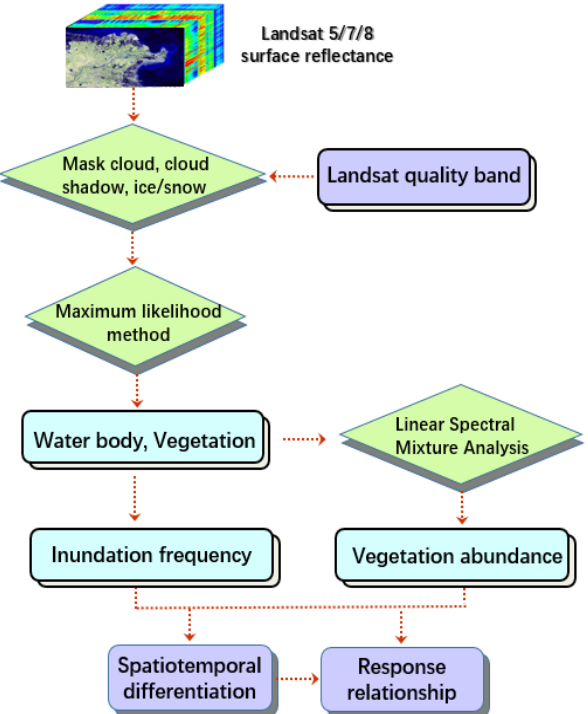
Figure 2. The flowchart of the extraction of surface water bodies and vegetation abundance in the YRD.